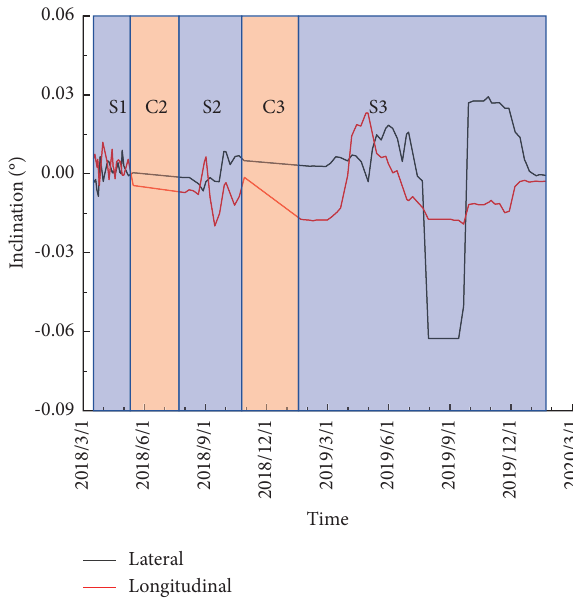
Figure 13: The change of the inclination during caisson excavation.